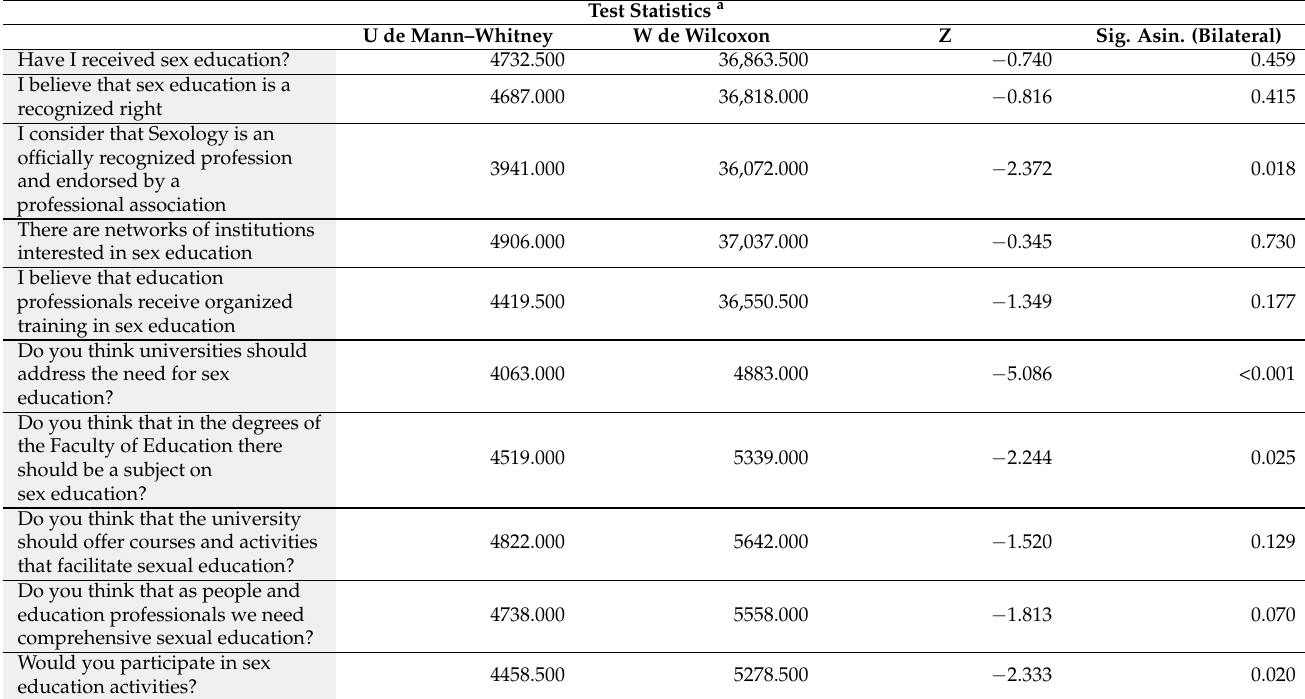
Table 4. Significant differences by Mann–Whitney U